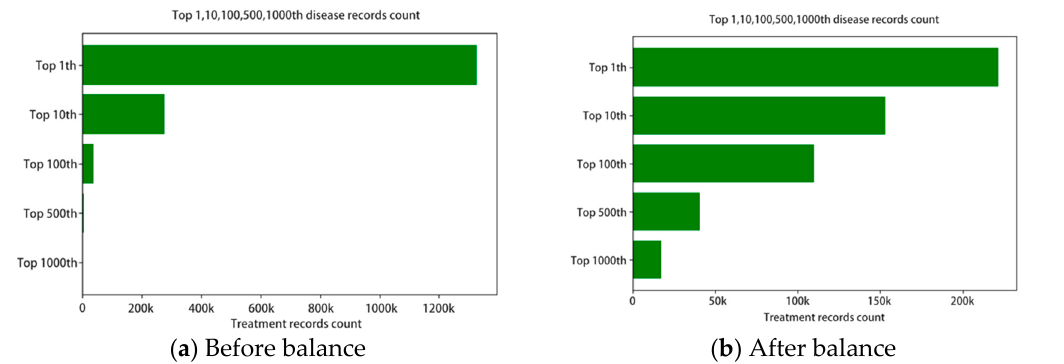
Figure 2. The disease record count distributions.